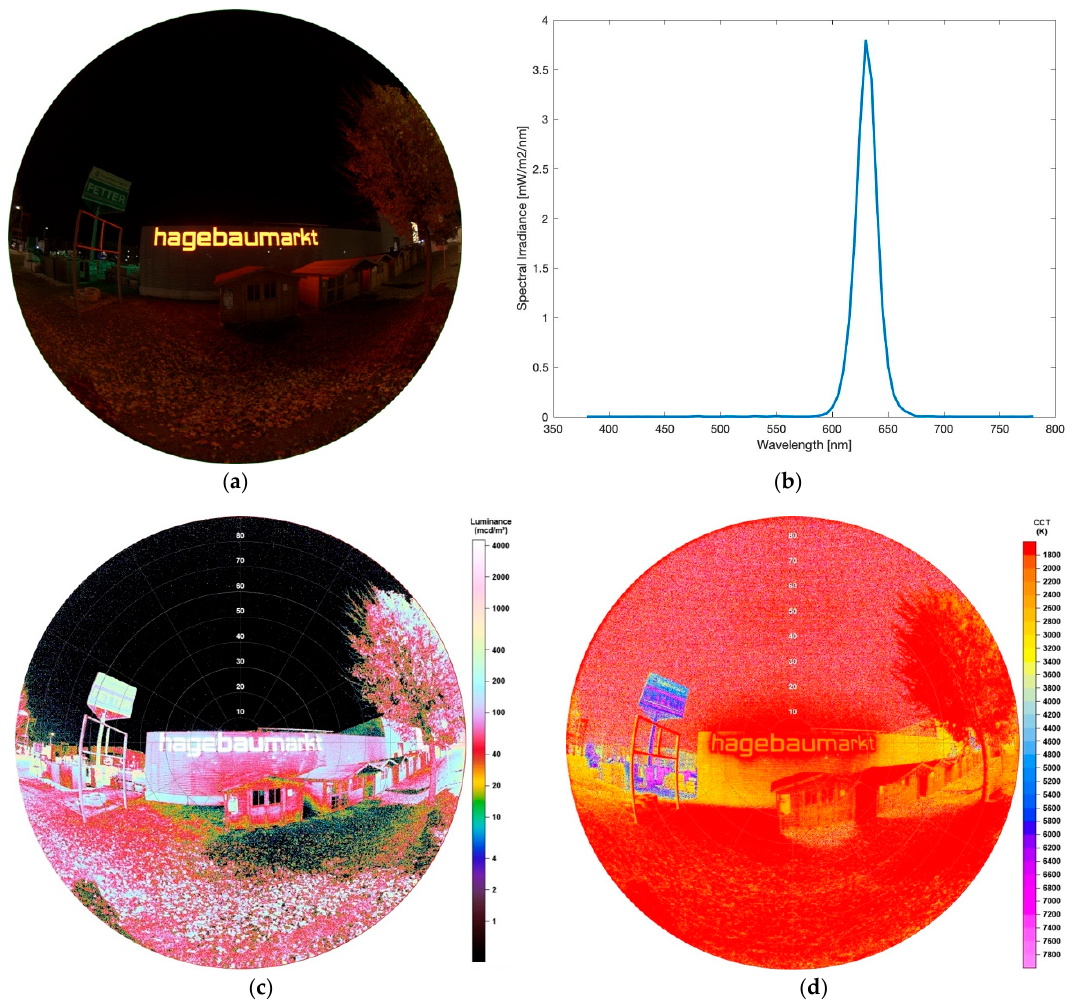
Figure 15. ( a ) Image of the illuminated monochromatic billboard during night-time, taken with fisheye lens for detailed analysis (date: 24.10.2019, 21:20 h; exposure time: 0.1 s); ( b ) Spectrum of billboard observed; ( c ) Luminance matrix as displayed by SQC; ( d ) CCT matrix as displayed by SQC. Please note a higher CCT scale up to 7800 K.